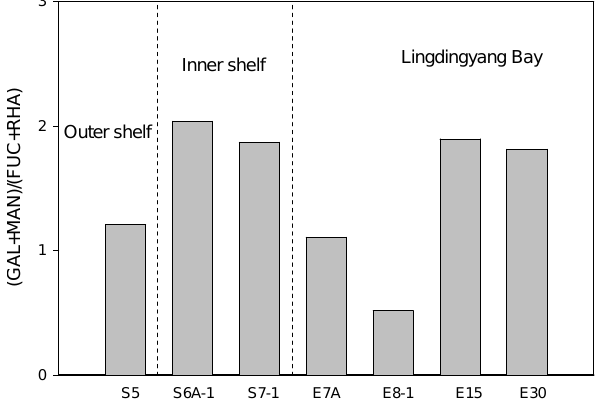
Fig. 10. The ratio of (GAL+MAN)/(FUC+RHA) in the surface sed- iments collected from Lingdingyang Bay and the SCS shelf.